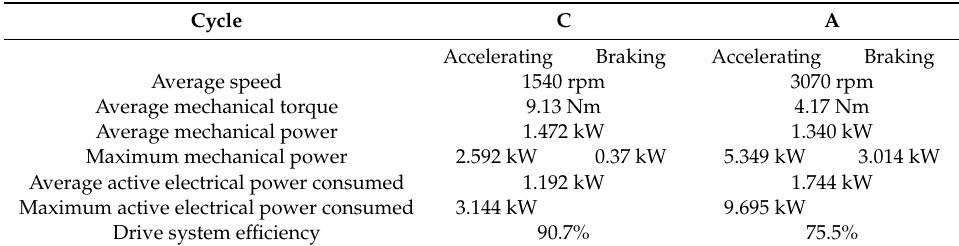
Table 5. Measurement results for C and A cycle of the trolley travel drive.